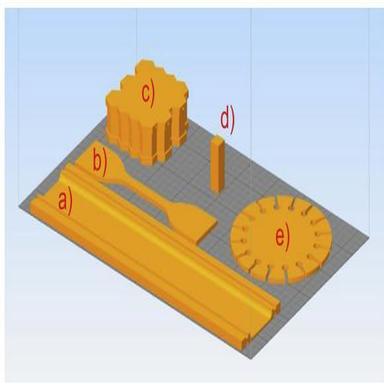
Test part build orientations. a) Planar, b) Uniaxial, c) Honeycomb geometry, d) Cuboid for μCT Scanning, e) Equi-biaxial.